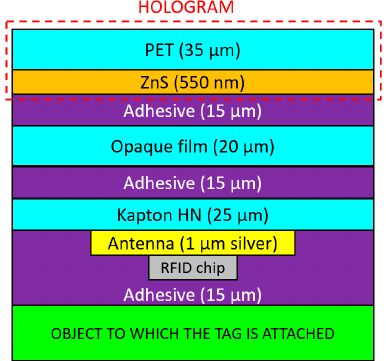
Figure 1. Cross-section of the proposed multilayer label.